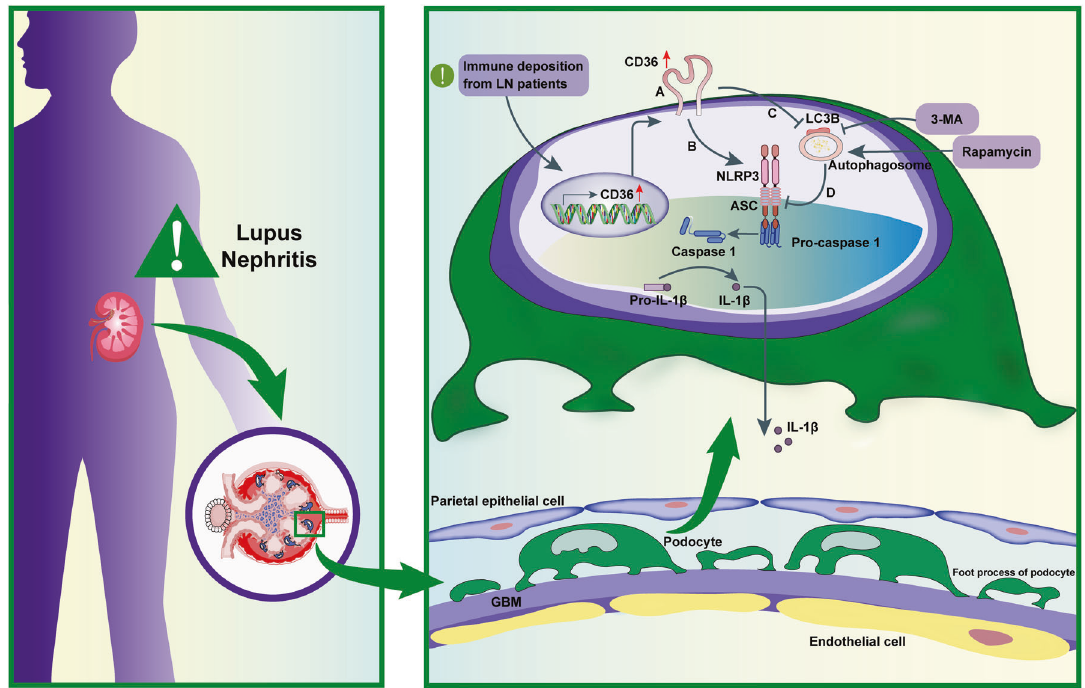
Fig. 5 Mechanistic diagram. A CD36 was upregulated in the podocyte of lupus nephritis. B Elevated CD36 promoted NLRP3 in fl ammasome and podocyte injury. C CD36 negatively regulated autophagy. D Enhancing autophagy could reduce NLRP3 in fl ammasome activation and podocyte